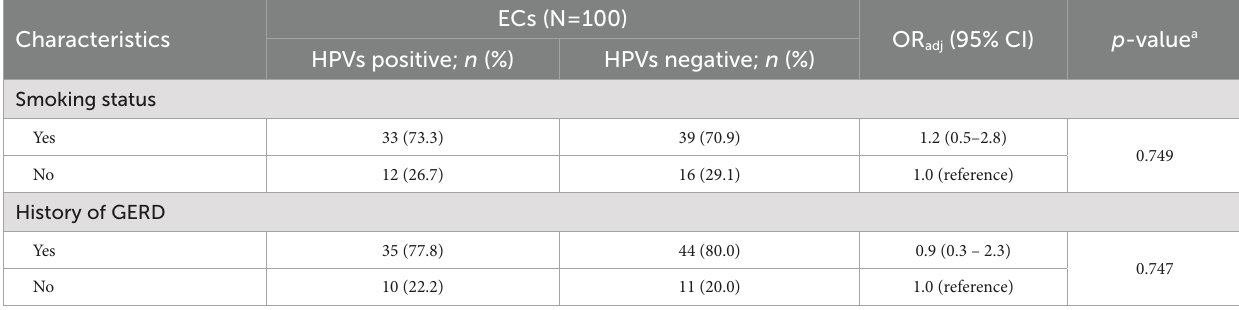
Characteristics